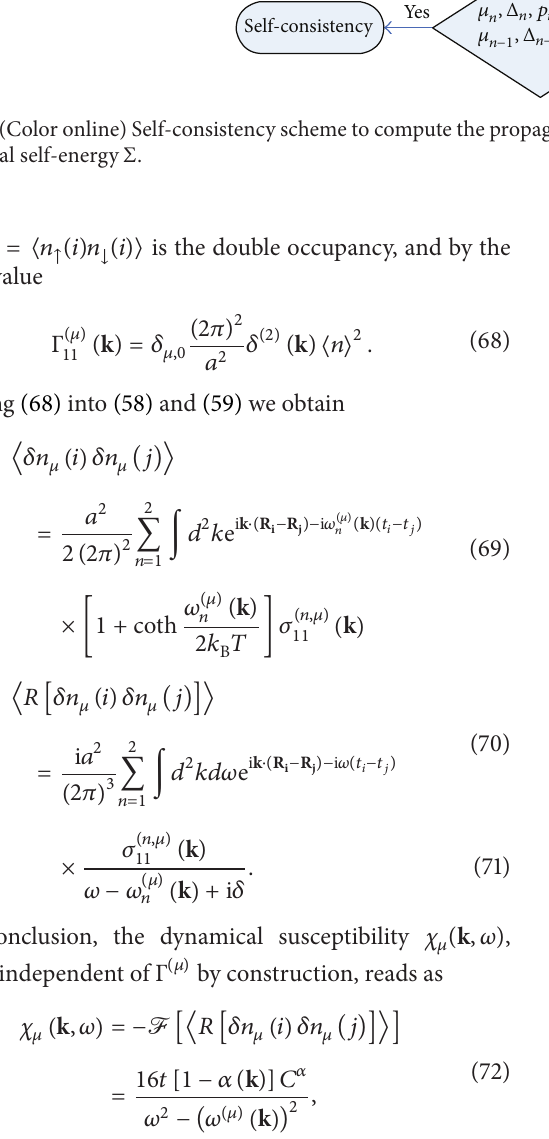
Figure 1: we first compute 𝐺 0 ( k , 𝜔) and 𝜒 𝜇 ( k , 𝜔) in the two- pole approximation, then Σ( k , 𝜔) , and consequently 𝐺( k , 𝜔)